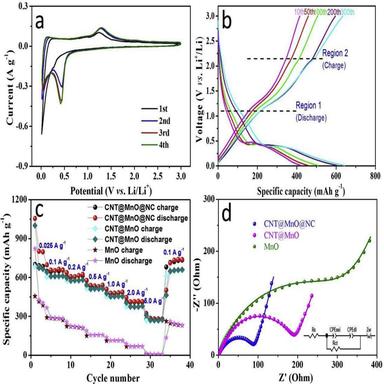
Electrochemical performance of the CNT@MnO@NC electrode: (a) Cyclic voltammograms of the initial four cycles under a scan rate of 0.1 mV s-1 , (b) typical discharge-charge profiles with a current of 1 A g-1 . (c) Rate performances and (d) Nyquist plots before cycling of CNT@MnO@NC, CNT@MnO and MnO electrodes. The insert in (c) represents the equivalent circuit model, in which Rs shows the internal resistance of solution and electrodes, Rct refers to the charge transfer resistance, CPEsei and CPEdl suggest t